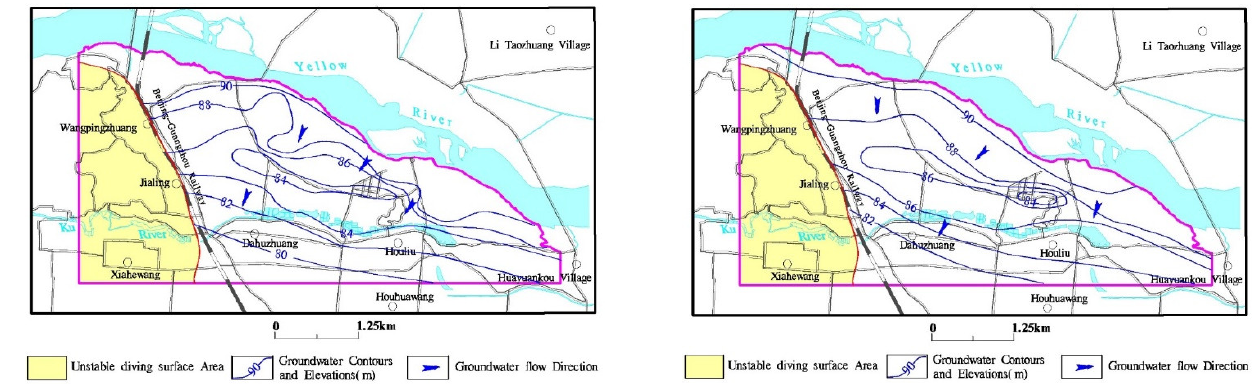
Figure 4. Contour map of the shallow groundwater level in the study area (( Left )—April 2021; ( Right )—September 2021).